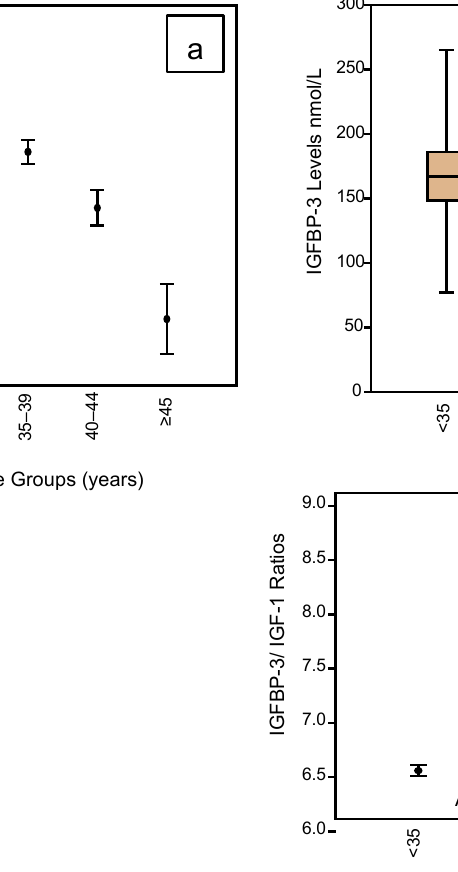
Figure 3. Mean and whisker diagrams showing the IGF-1 profile according to the age groupings of the 1633 women who completed an Assessment Cycle prior to any ART treatments. There is a linear reduction in the IGF-1 mean levels with advancing age (mean and whisker plot ( a ); p < 0.001), but there is no significant change in IGFBP-3 levels across the age ranges (box and whisker plot ( b )). This translates to a significant rise in the IGFBP-3 / IGF-1 ratio with advancing age (mean and whisker ( c ); p < 0.001).